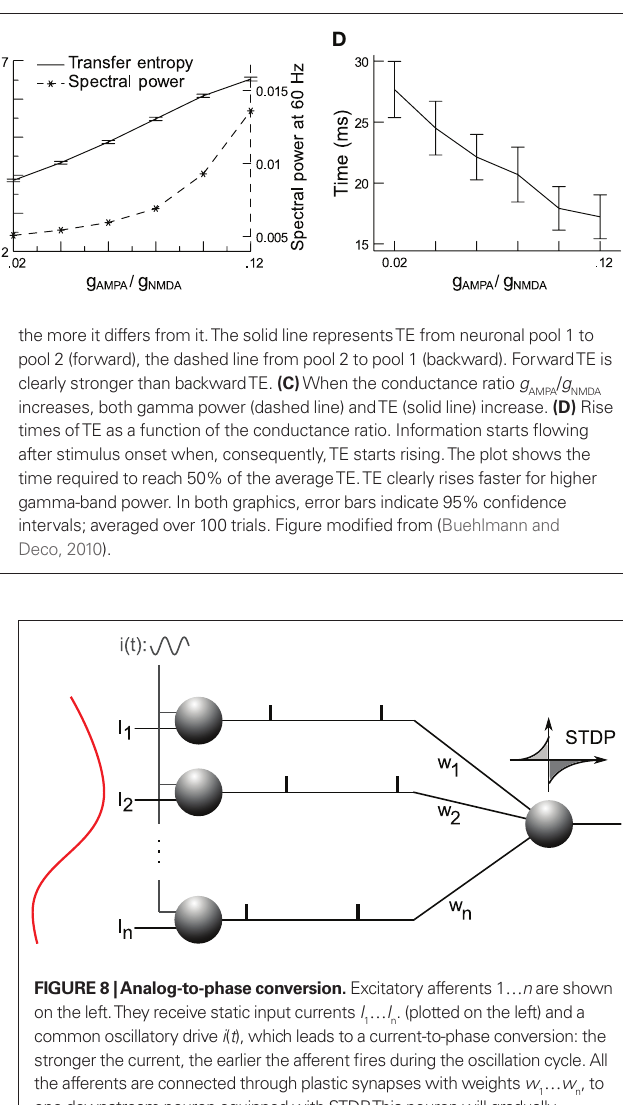
. (plotted on the left) and a … I 1 n , to … w 1 n